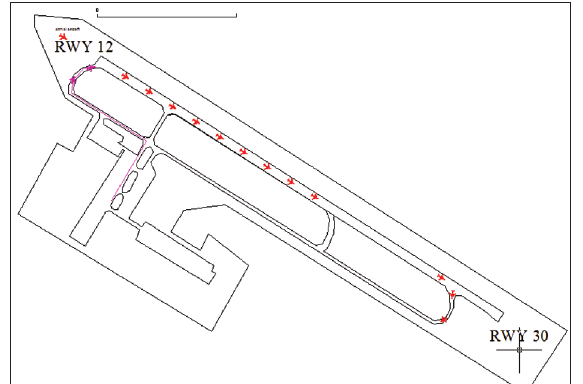
Fig. 3. The present layout of Nikola Tesla Airport